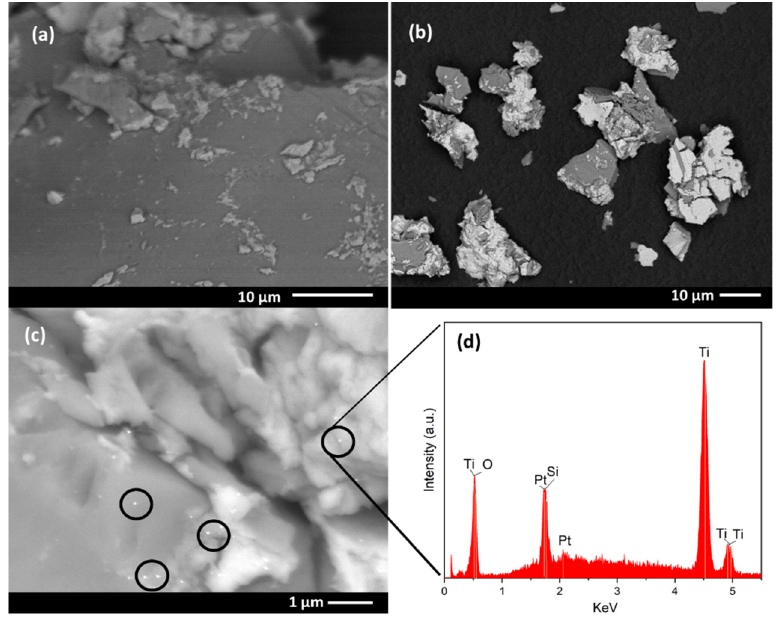
Figure 4. SEM images of 0.25%Pt-TiO 2 /SiO 2